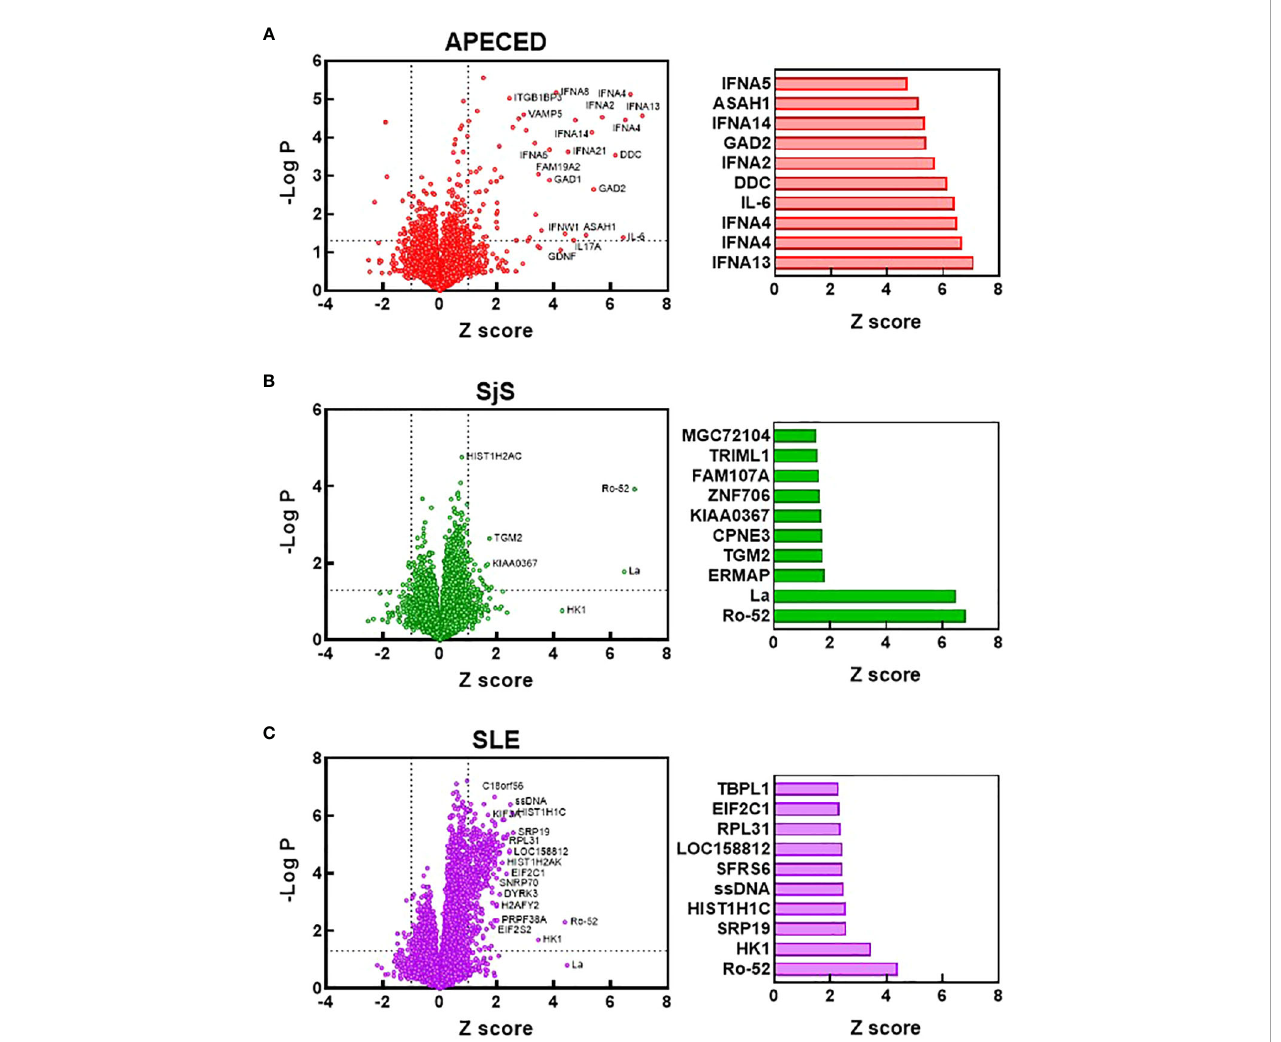
FIGURE 2 Identi fi cation of the most signi fi cantly elevated autoantibodies. Volcano plots were constructed based on the ProtoArray data for the APECED (A) , SjS (B) , and SLE (C) patient groups. Dotted lines de fi ne reactivities with a Z scores >1 and a p value of <0.05 (t test) compared with the HC group. Notable reactivities are labeled. Bar charts show the 10 reactivities that were signi fi cantly different from HCs (p<0.05) with the largest Z scores for each disease. APECED, autoimmune polyendocrinopathy – candidiasis – ecto-dermal dystrophy; SLE, systemic lupus erythematosus; SjS, Sjogren ’ s